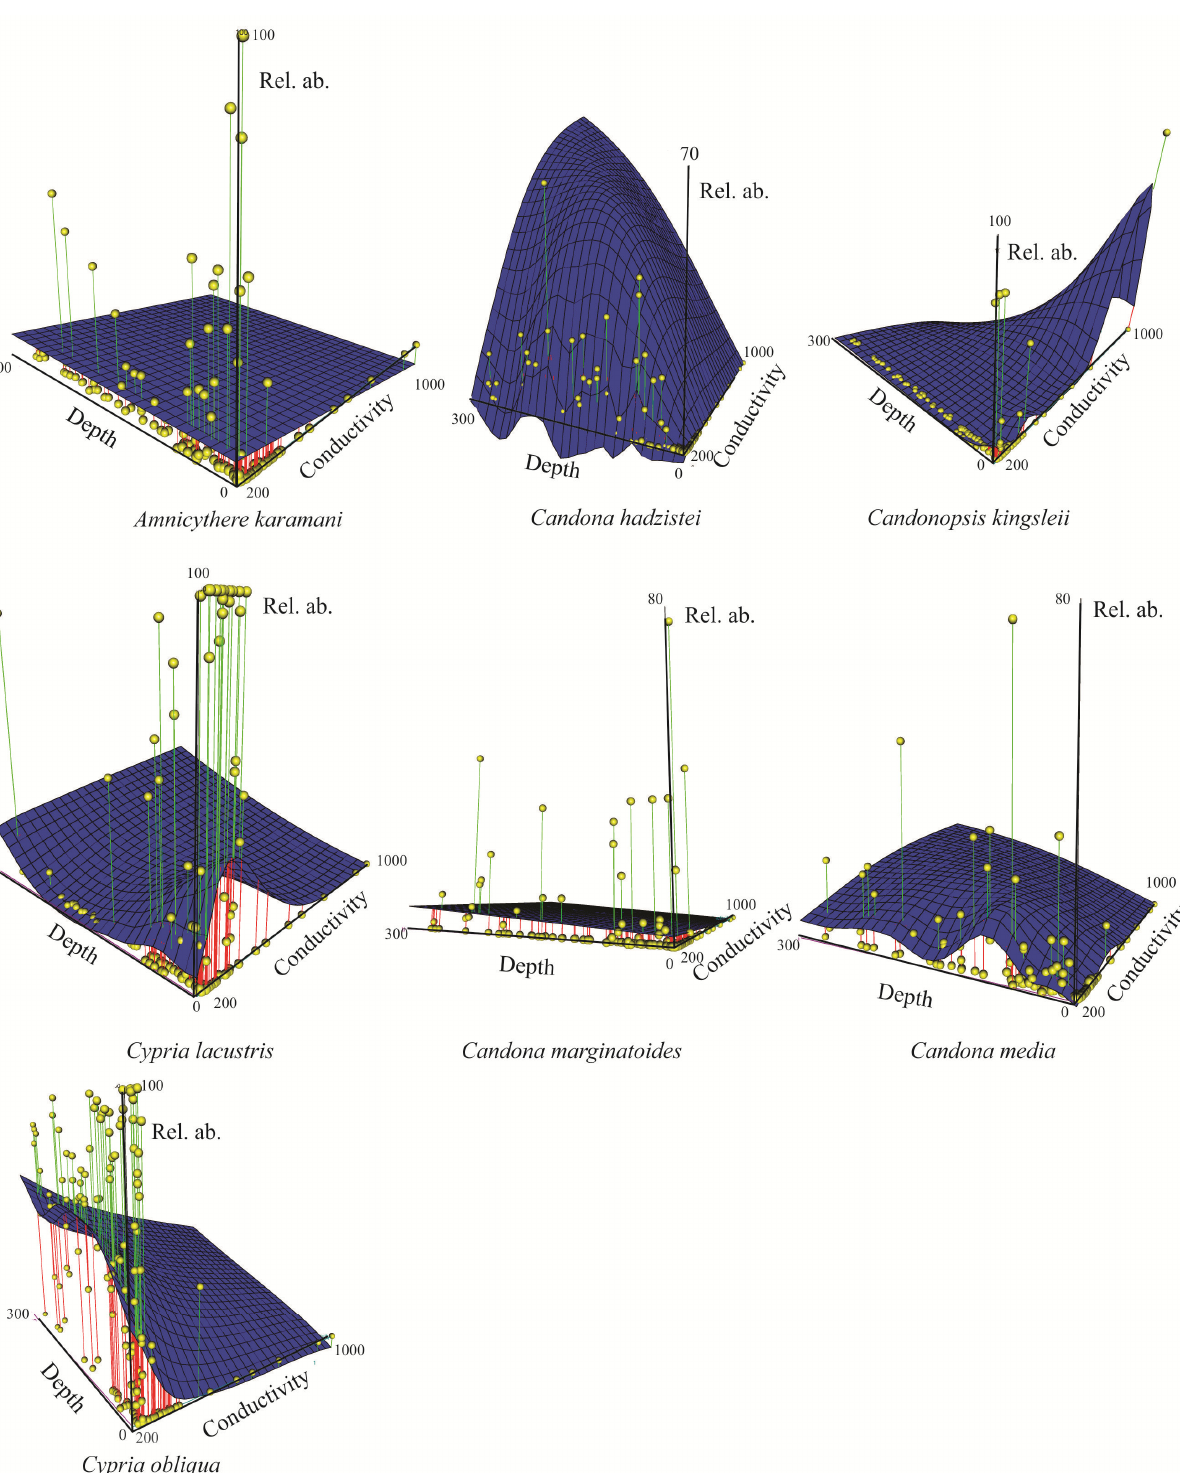
Figure 7. 3D scatter plot of species relative abundance (%) as a function of depth (m) and water conductivity ( μ S cm − 1 ) reported for species collection sites. Vertical lines and spheres indicate the species relative abundances. Blue surface shows modeled abundance through smooth regression. Only species present in ≥ 10 sites are